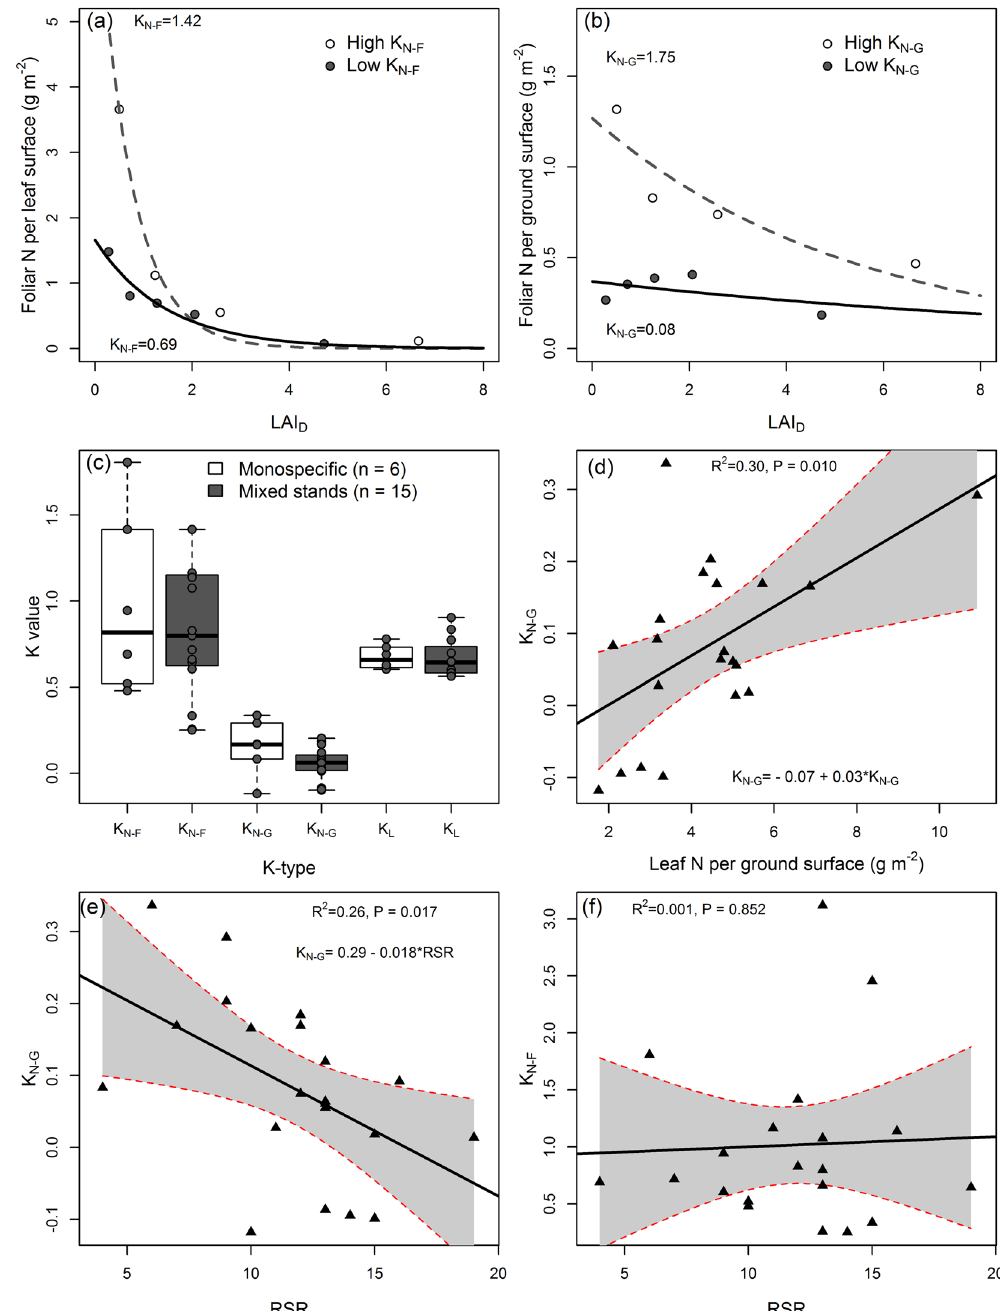
Figure 2. ( a ) Examples of two plots (no. 1 and 21 from Table S1) with contrasting K N-F values estimated with eq. (2) from the relationship between foliar N per leaf surface area and leaf area index at different depths (LAI D ) ( b ) Same as for Fig. 2a but for the N allocation coefficient based on foliar N per ground surface area ( K N-G ). ( c ) Boxplots depicting the median and distributions of K N-F , K N-G and light attenuation coefficients ( K L ) in monospecific and mixed stands. ( d ) Relationship between the total foliar N content per ground surface area (N G ) and K N-G . ( e ) Relationship between realised species richness (RSR) and K N-G . ( f ) Relationship realised species richness (RSR) and K N-F